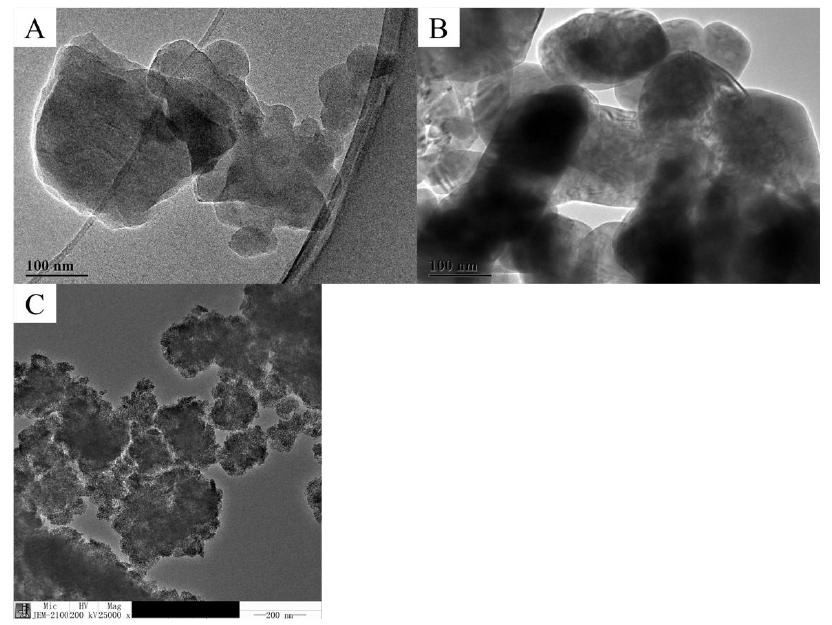
Figure 1. Transmission electron microscopic (TEM) images of ( A ): Carbon 60 NMs; ( B ): Copper oxide NMs and ( C ): Titanium dioxide NMs.